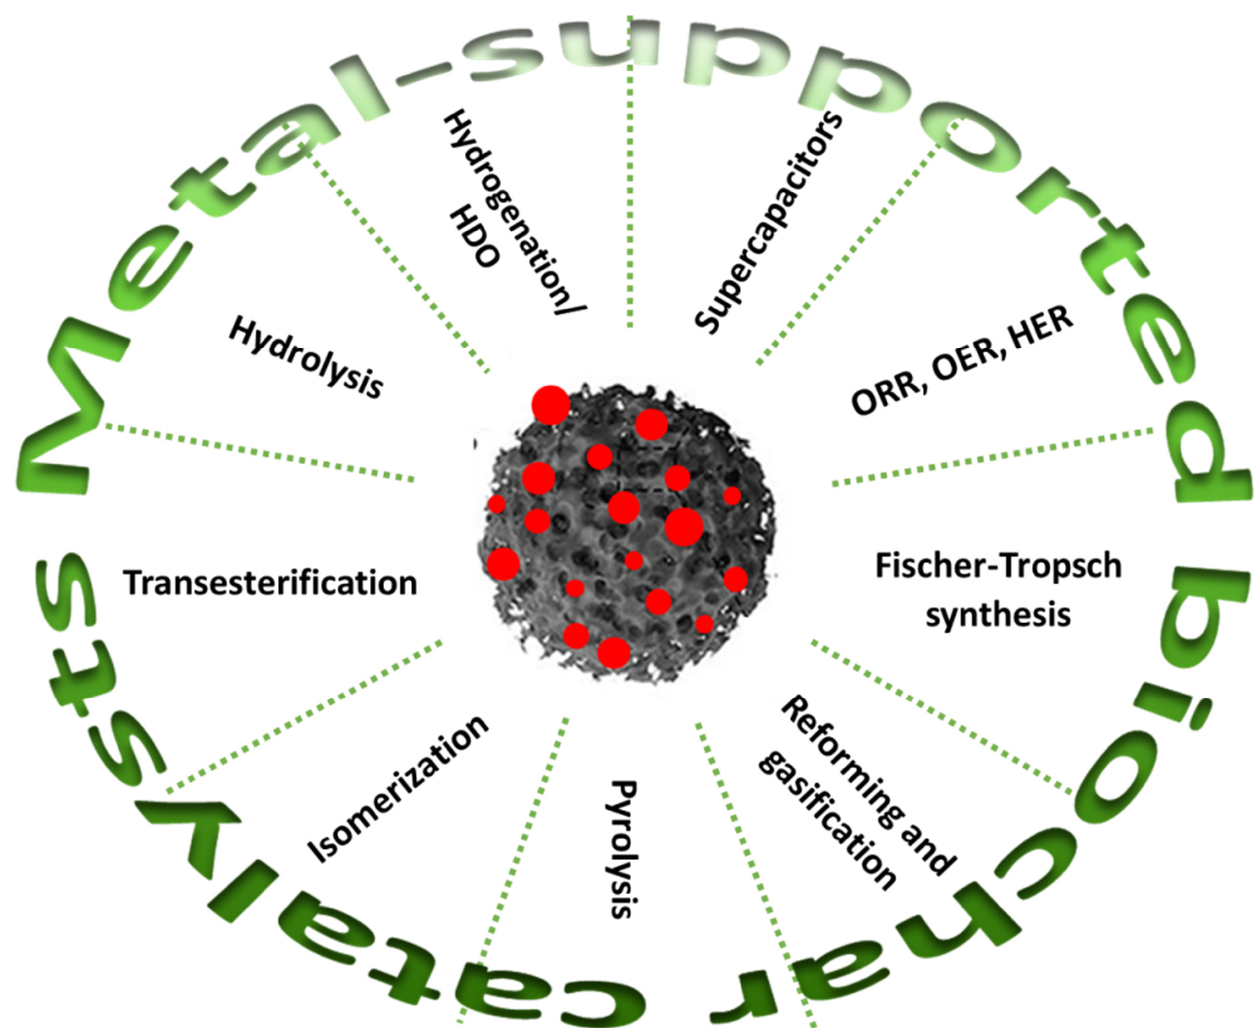
Figure 1. Overview of M-BCH applications in sustainable catalytic processes.